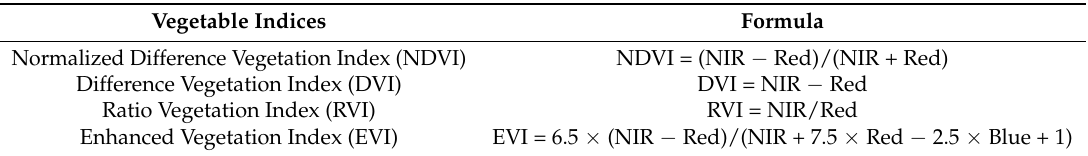
Table 2. Vegetation indices calculated from the Landsat